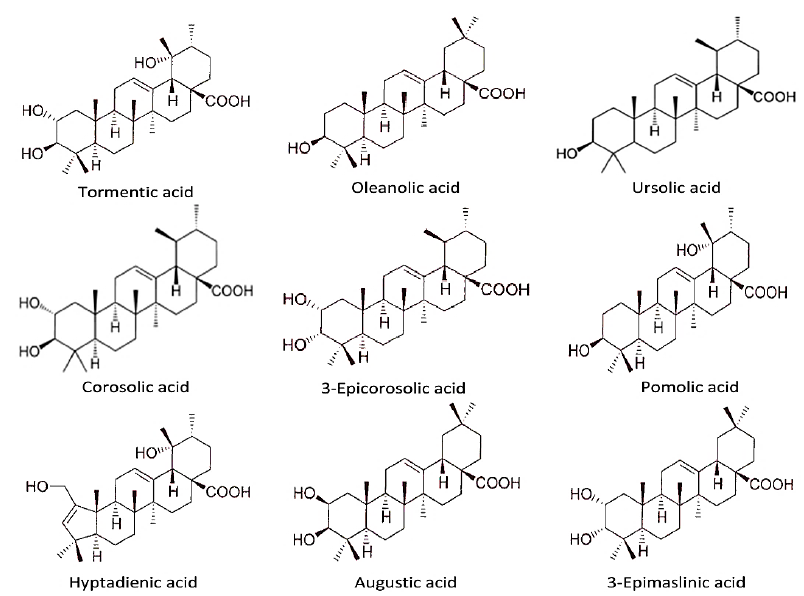
Figure 3. The chemical structures of triterpene acids identified in P. frutescens ; tormentic acid, oleanolic acid, ursolic acid, corosolic acid, 3-Epicorosolic acid, pomolic acid, hyptadienic acid, augustic acid, 3-Epimaslinic acid.